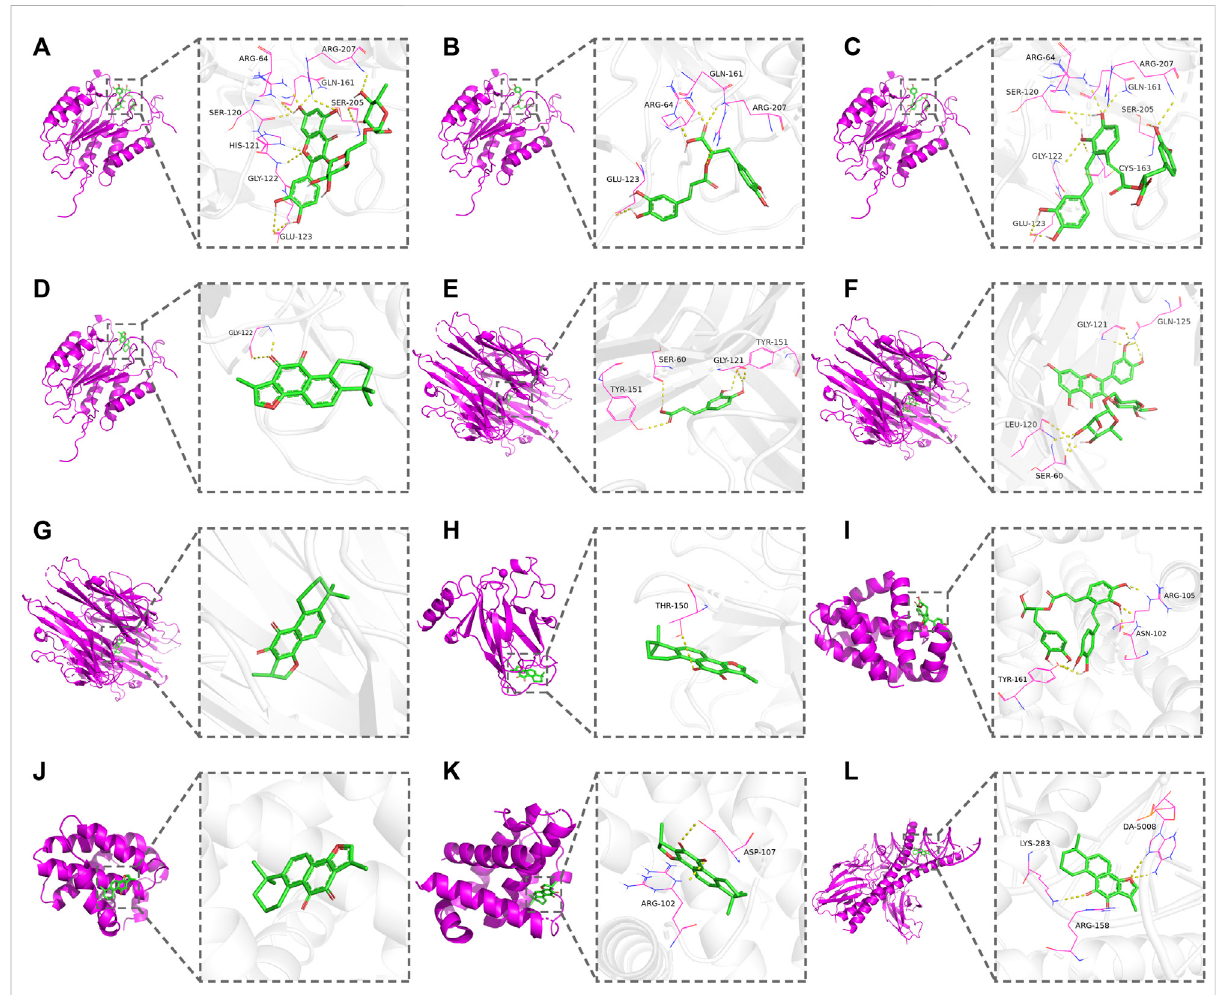
FIGURE 5 Docking patterns of the active compounds and the corresponding apoptosis pathway-related targets. (A) CASP3 – rutin. (B) CASP3 – rosmarinic acid. (C) CASP3 – salvianolic acid A. (D) CASP3 – tanshinone IIA. (E) TNF – caffeic acid. (F) TNF – rutin. (G) TNF – cryptotanshinone. (H) TP53 – tanshinone IIA. (I) BCL2 – salvianolic acid A. (J) BCL2 – tanshinone IIA. (K) BCL2L1 – cryptotanshinone. (L) FOS – tanshinone